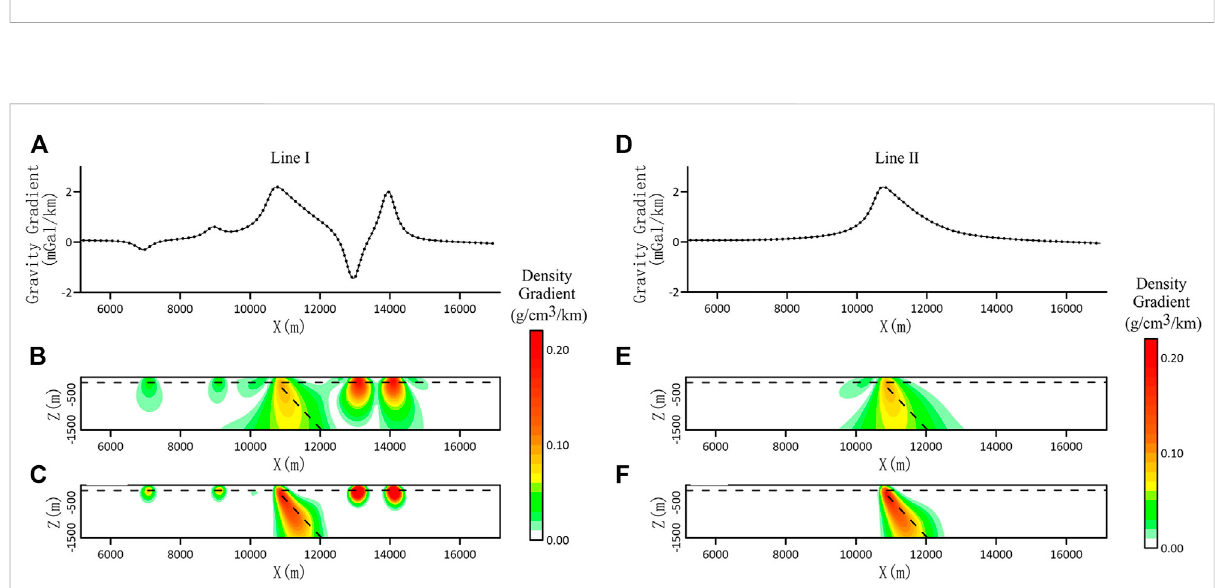
FIGURE 7 Gravity curves and inversion results pro fi les of lines I and II. (A) Gravity anomaly curve of line I. (B) Slice the inversion result of line I without focusing constraint. (C) Slicing of line I focusing inversion results. (D) Gravity anomaly curve of line II. (E) Slice the inversion result of line II without focusing constraint. (F) Slicing of II line focusing inversion results.